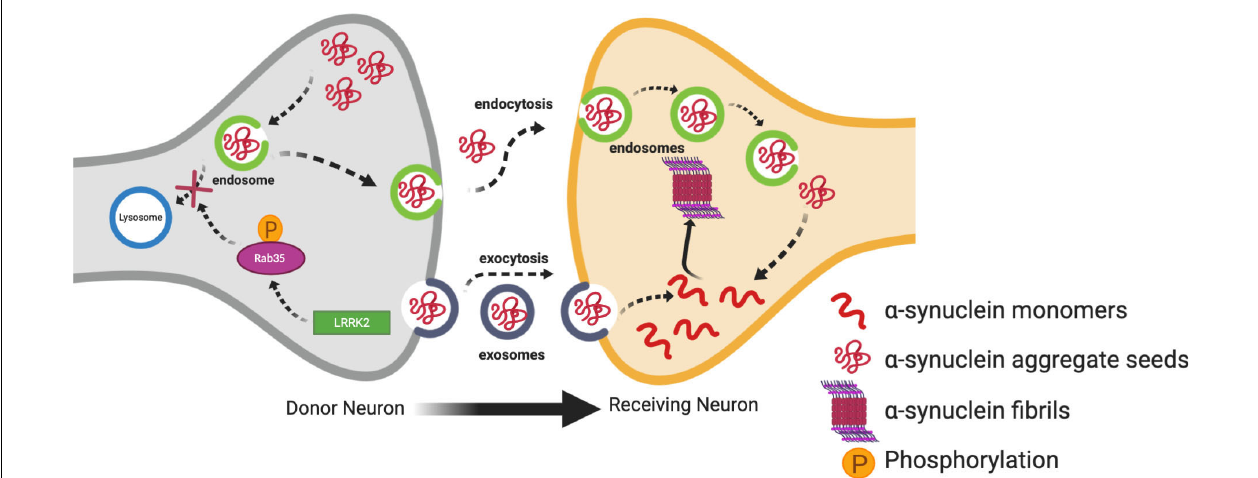
FIGURE 2 | Contribution of mutant LRRK2 to cell-to-cell transmission of α -synuclein. Increased kinase activity of mutant LRRK2 can phosphorylate Rab35 affecting its interaction with its substrates, and eventually preventing the endosome-lysosmal degradation of α -synuclein aggregates. This in turn can increase the mobile cytosolic pools of α -synuclein aggregate seeds which can get released into the extracellular space in exosomes. These seeds can then be taken up into the cytosol of neighboring neurons where they can promote aggregation of α -synuclein monomers into oligomers and fibrils.